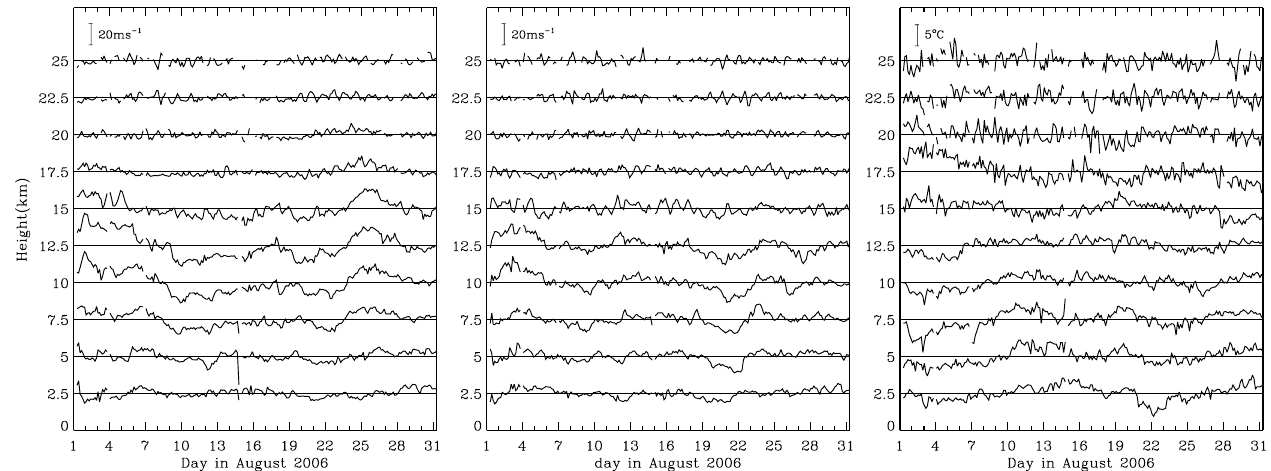
Fig. 1. The raw time series for the zonal wind (left), meridional wind (middle) and temperature (right) disturbances at every 2.5km in August 2006.